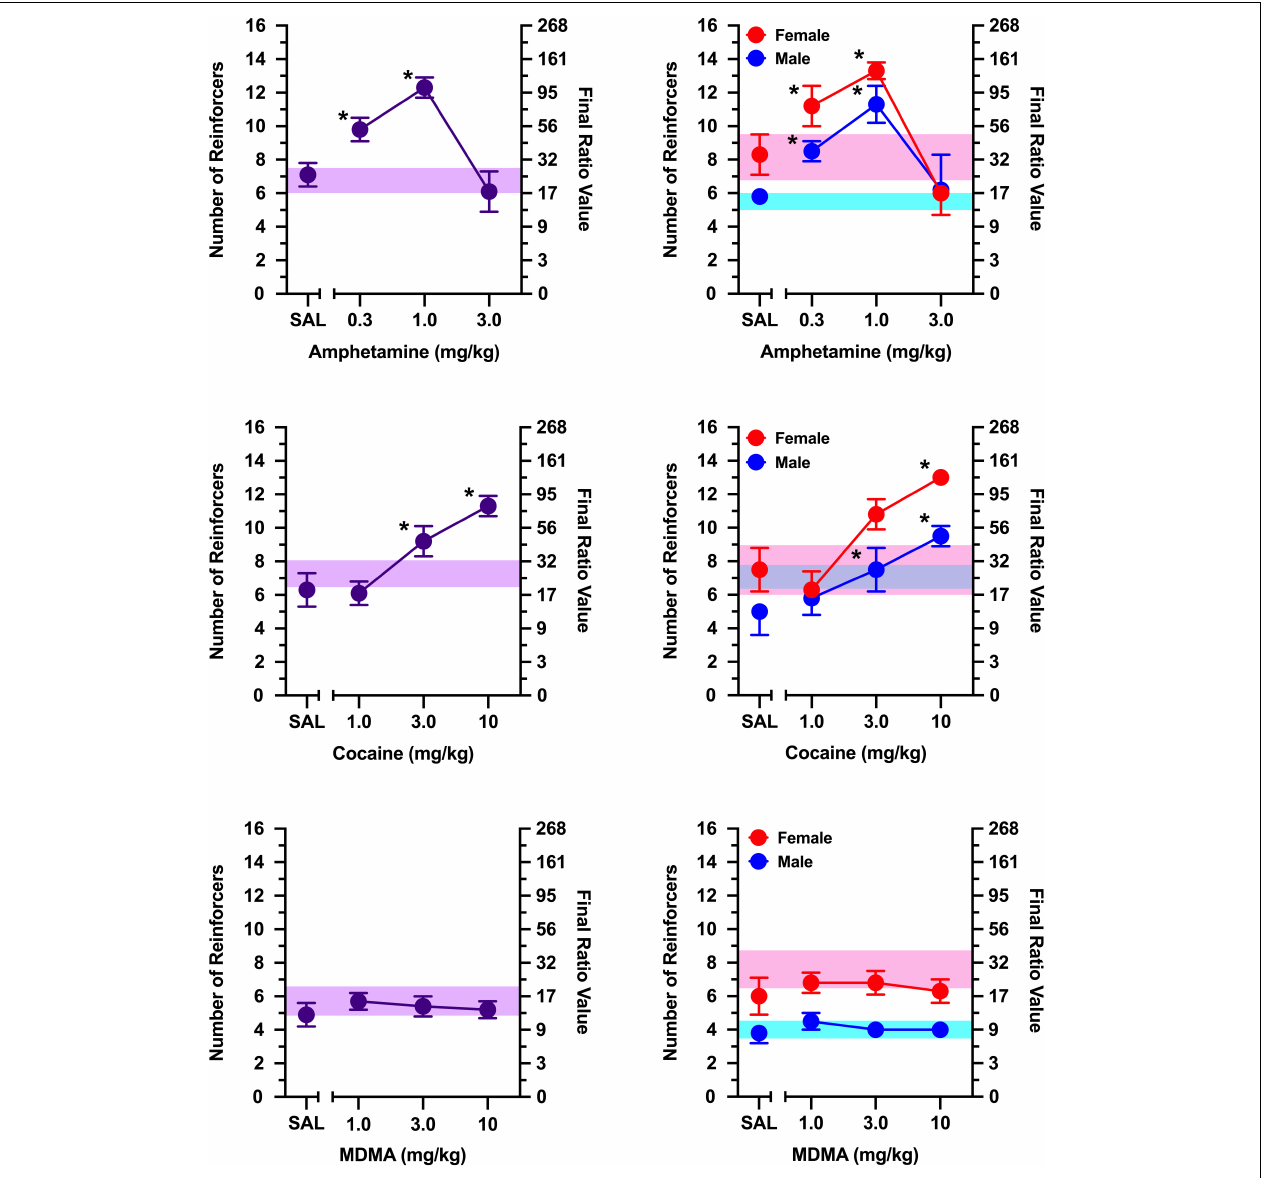
FIGURE 3 | The effects of d -amphetamine (top) , cocaine (middle) , and MDMA (bottom) on breakpoints maintained by a social stimulus (i.e., sex- and age-matched partner). Left panels depict data collapsed across males and females. Right panels depict data collected in males and females separately. Left axes reflect breakpoint defined as the number of reinforcers obtained; right panels depict breakpoint as final ratio value completed. Bottom axes represent the effects of saline (SAL) and doses of d -amphetamine, cocaine, and MDMA expressed in mg/kg. Asterisks (*) indicate significant difference relative to saline. Shaded regions indicate variance in breakpoint during non-injection control sessions (purple = collapsed across sex; blue = male; pink =